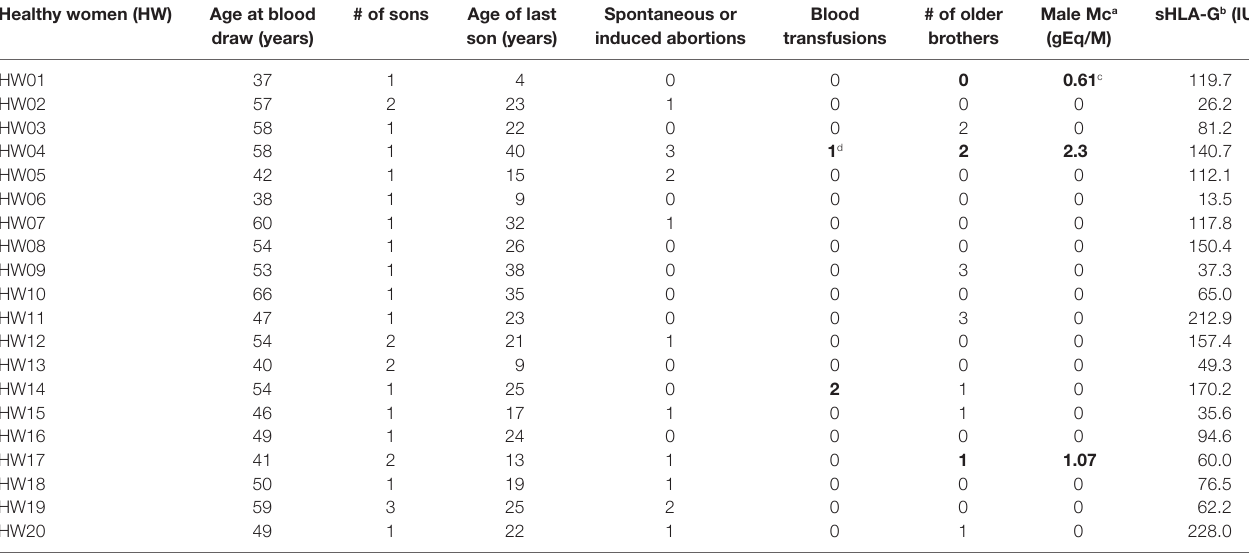
TaBle 2 | Obstetrical and clinical characteristics of healthy women quantified for male DNA and soluble HLA-G (sHLA-G) levels. healthy women